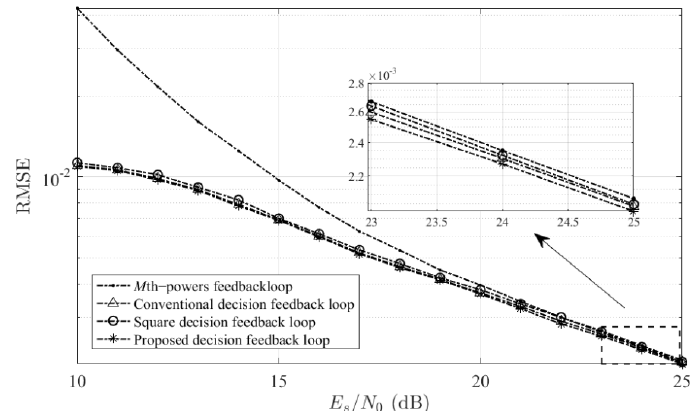
Figure 9. RMSE versus SNR for different feedback loops.